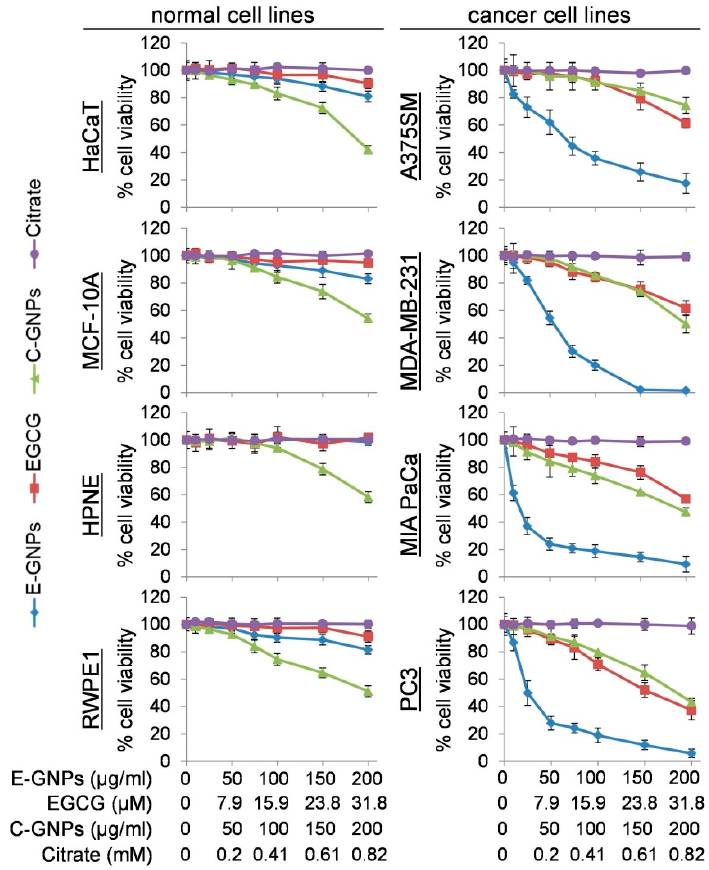
Figure 2. E-GNPs exhibit selective and superior anticancer activity. 5 × 10 3 noncancerous cells (HaCaT, MCF-10A, HPNE, and RWPE1) and cancerous cells (A375SM, MDA-MB-231, MIA PaCa, and PC3) were seeded in 96-well plates and treated with different concentrations of E-GNPs, epigallocatechin gallate (EGCG), C-GNPs, or citrate for 96 h, and cell viability was determined by WST-1 assay. Data represent the mean of triplicates ±